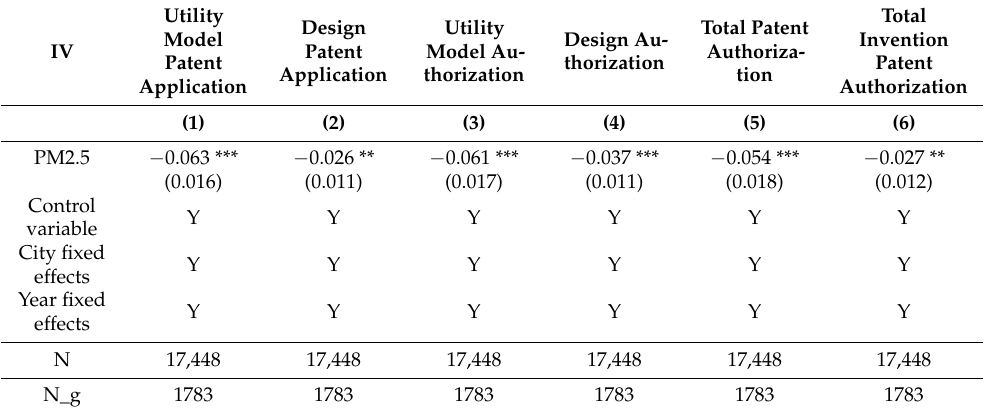
Table 3. Effects of PM2.5 on other types of